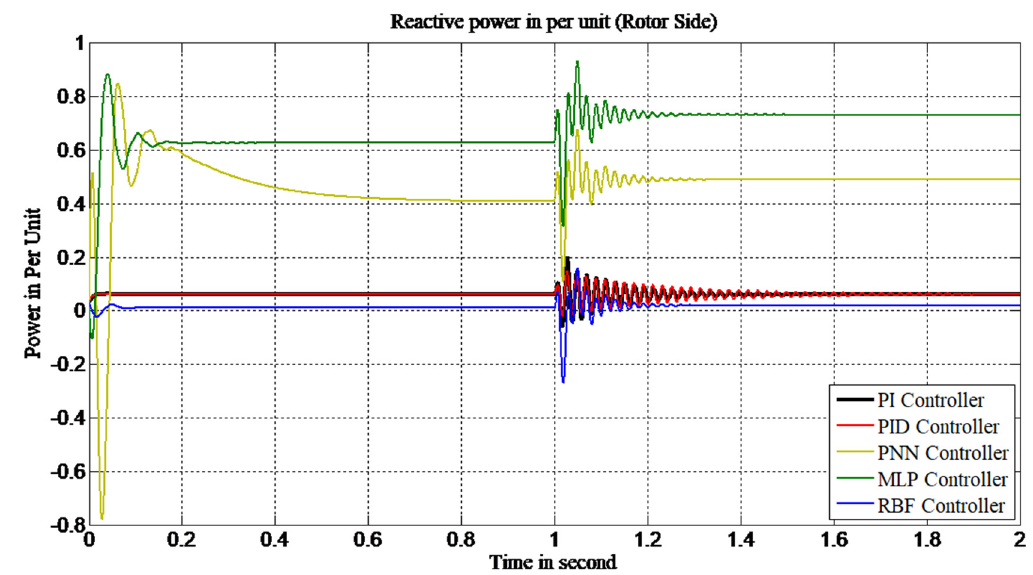
Figure 10. Reactive power at stator.